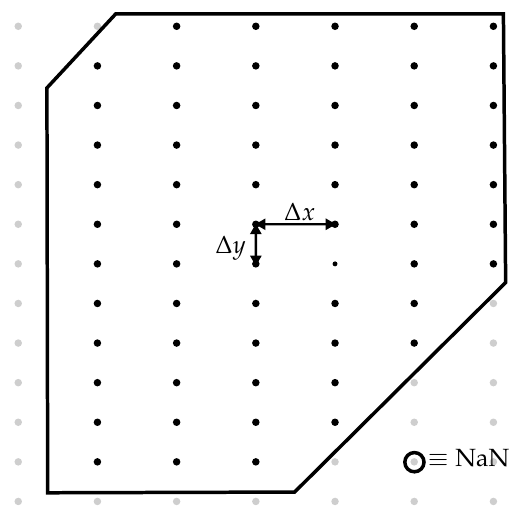
NaN ≡ Figure 3. Plan view of the computational grid. Although a regular grid of points with spacing ∆ x and ∆ y must be supplied, the domain can take a general shape by defining points outside of the delineating polygon (marked in solid black) with NaN values. Modified from [27].